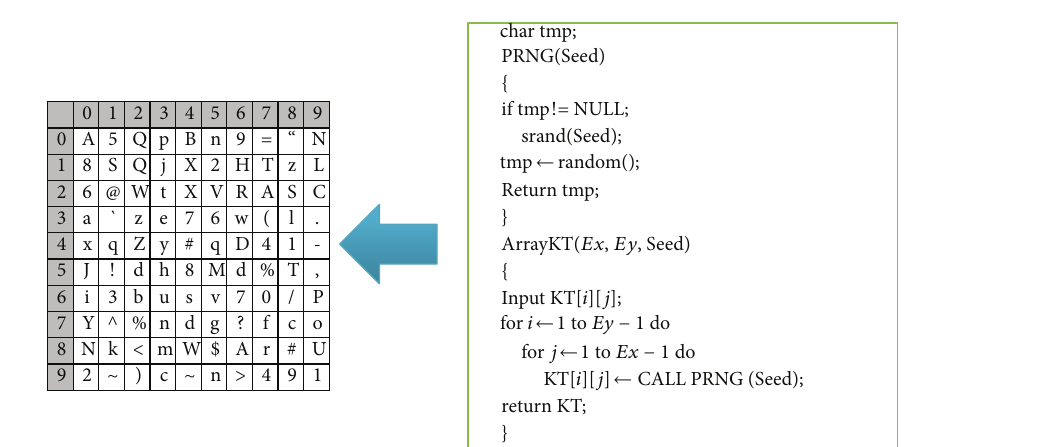
Figure 5: Pseudocode for key